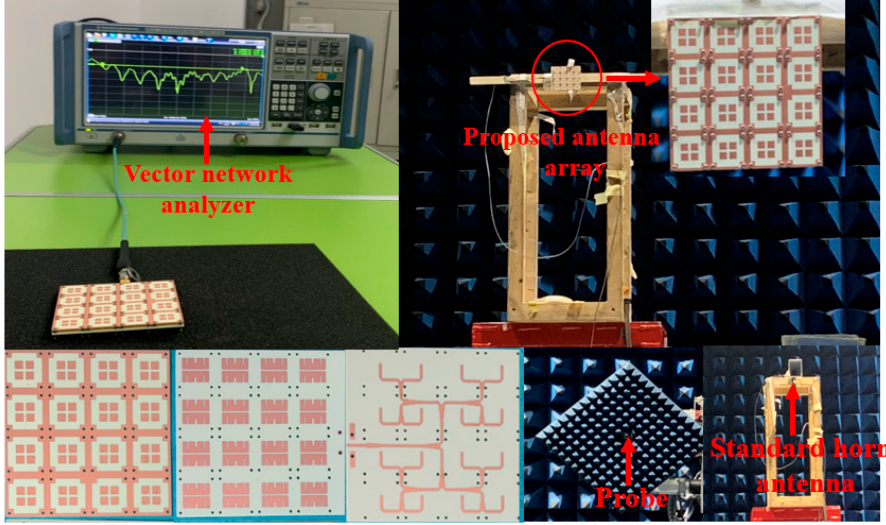
Figure 13. Photographs of the fabricated prototype and measurement setup.